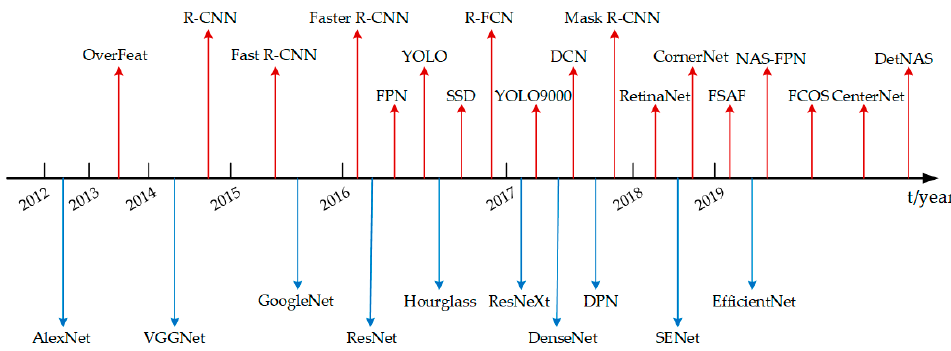
Figure 8. The research progress of target detection model and feature extraction networks.